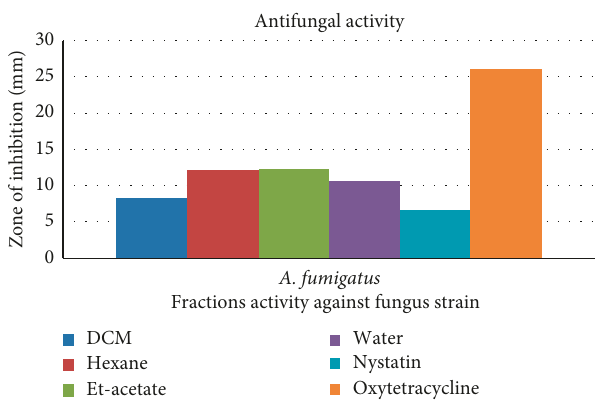
Figure 2: Inhibited zone shown by each fraction of Veronica biloba against fungus